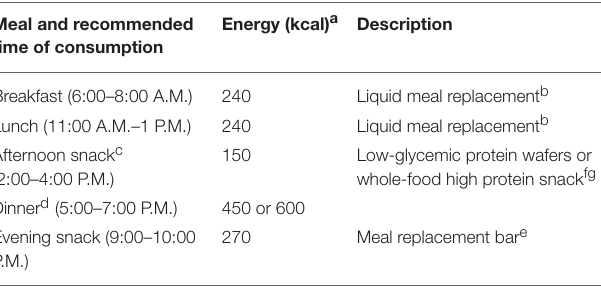
TABLE 1 | Composition of high-protein low-calorie diet.